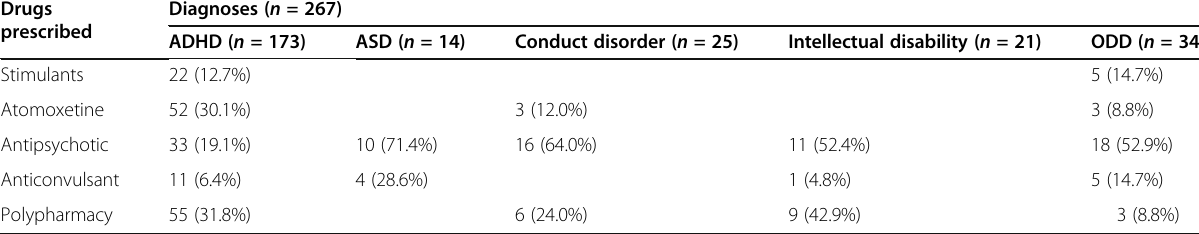
Table 3 Distribution of psychotropic drug prescription per each original diagnosis* Drugs prescribed